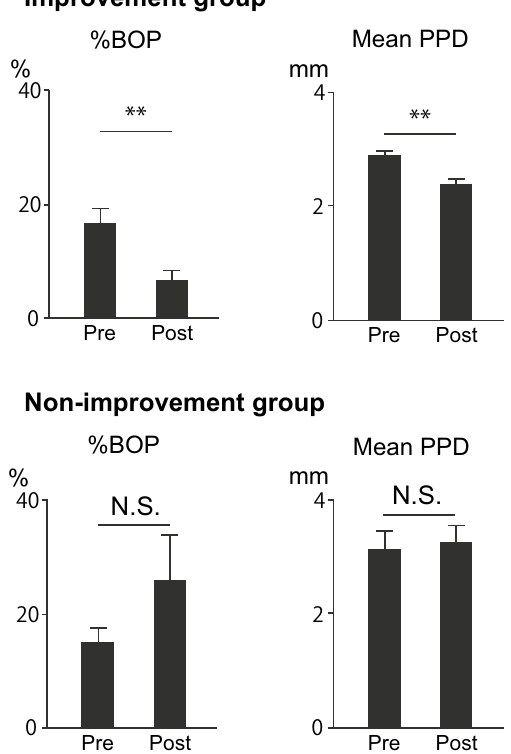
Figure 2. Results of periodontal treatment in patients. The %BOP is the percentage of periodontal pockets that bled when probed out of the total periodontal pockets. In the improvement group, both %BOP and mean PPD improved with periodontal treatment (n = 16, 11). Data are means ± SEM. **p < 0.01, paired Student’s t -test. BOP, bleeding on probing; PPD, probing pocket